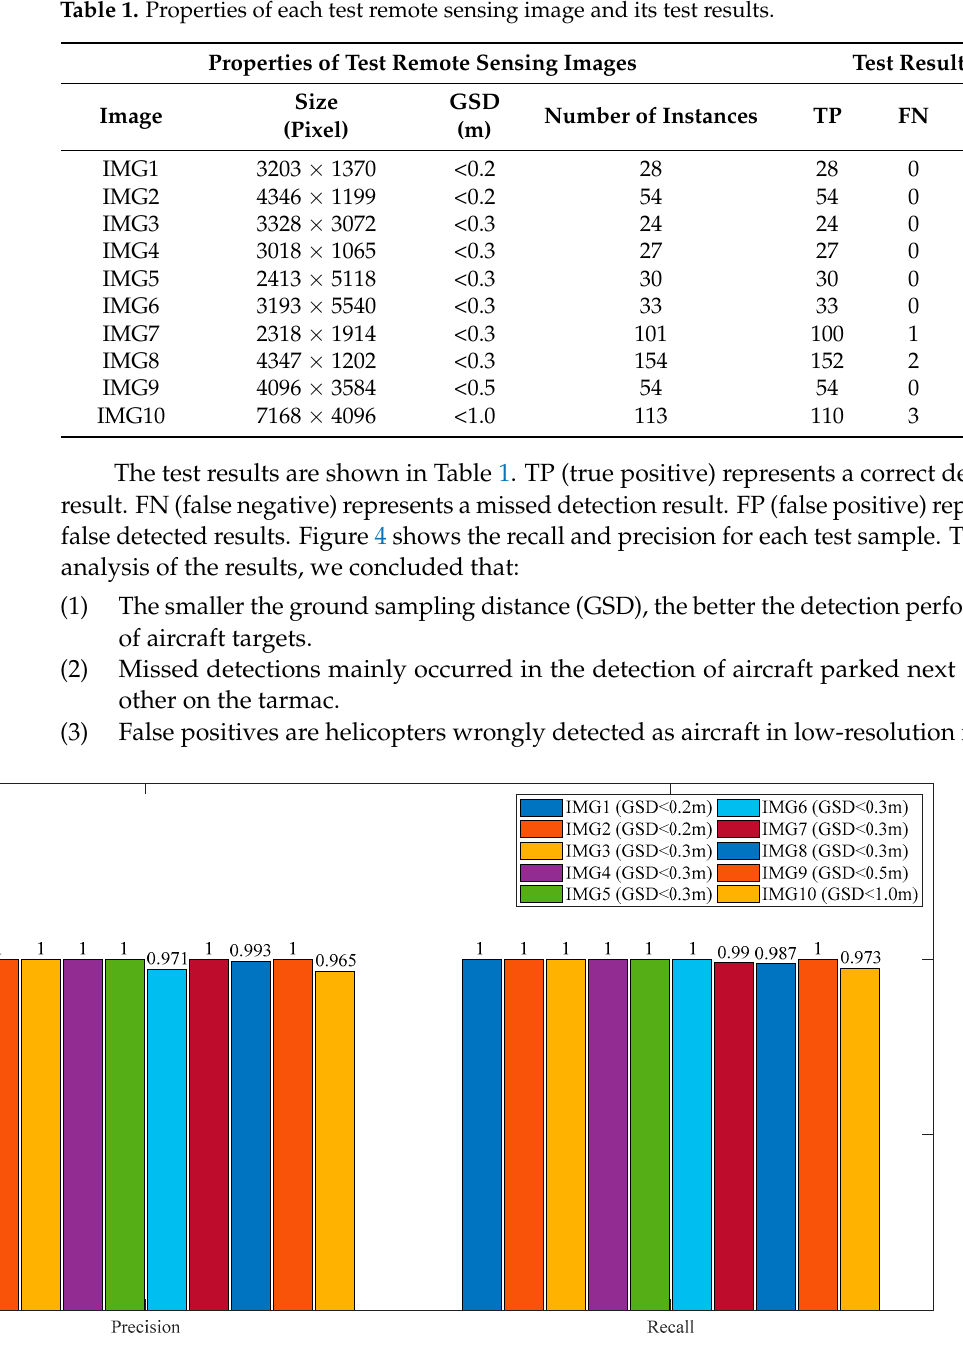
Table 1. Properties of each test remote sensing image and its test results.